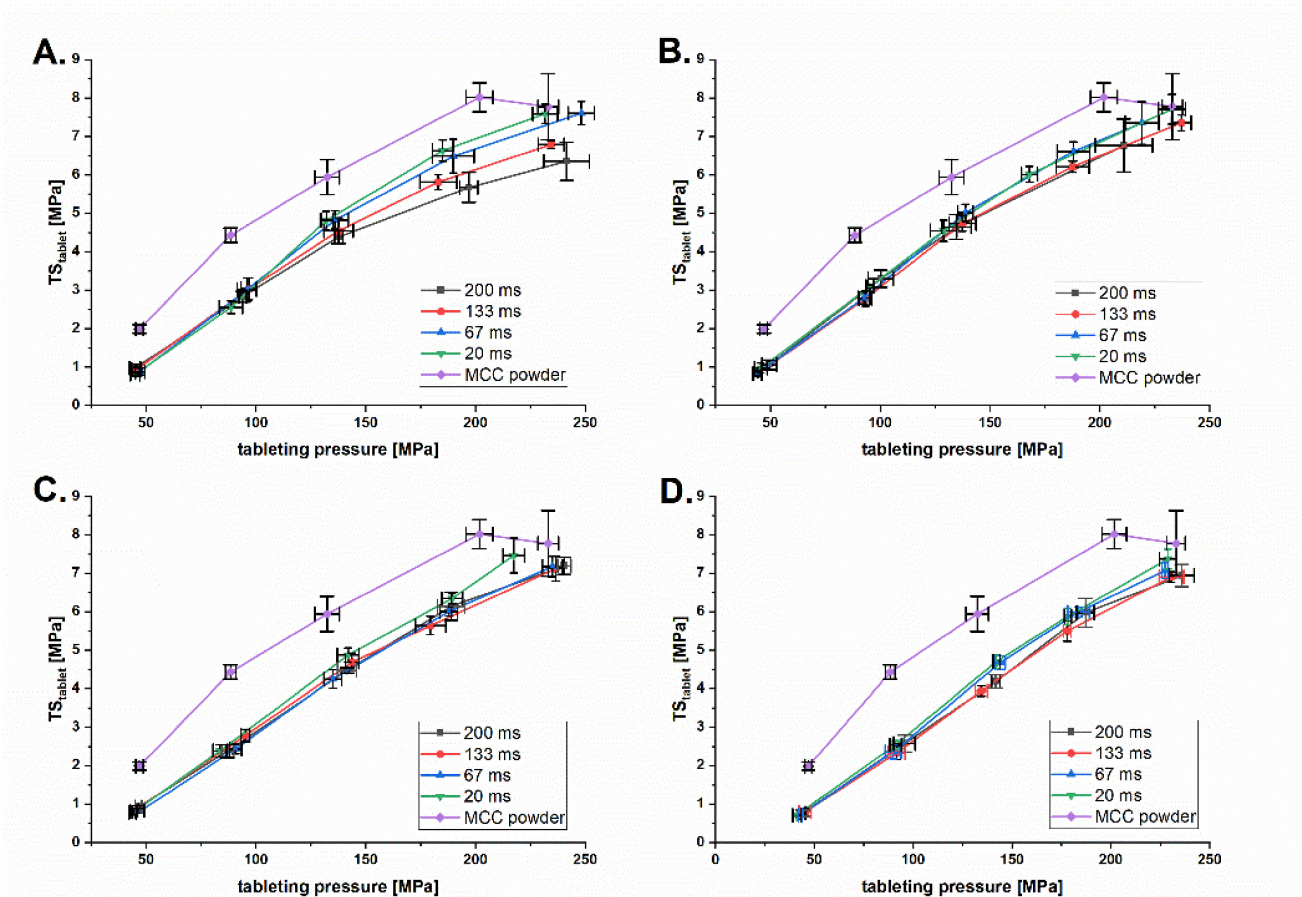
Figure 13. Tabletability plot of MCC granules at P max of 41 MPa ( A ), 56 MPa ( B ), 81 MPa ( C ) and 106 MPa ( D ) and DT of 20–200